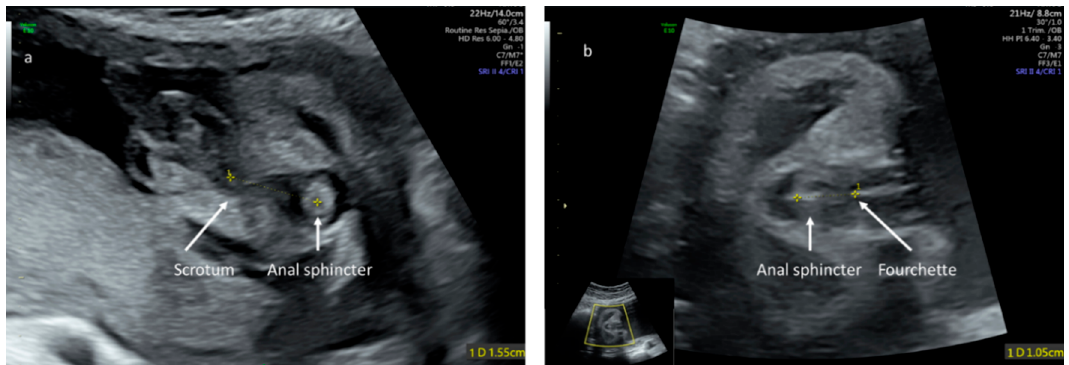
Figure 1. Sonographic landmarks for ano-genital distance measurement in male ( a ) and female ( b ) foetuses. In an axial view, at the level of the foetal perineum, the ano-genital distance is measured from the foetal anus to the base of the scrotum in the male or to the posterior commissure of the labia in females.